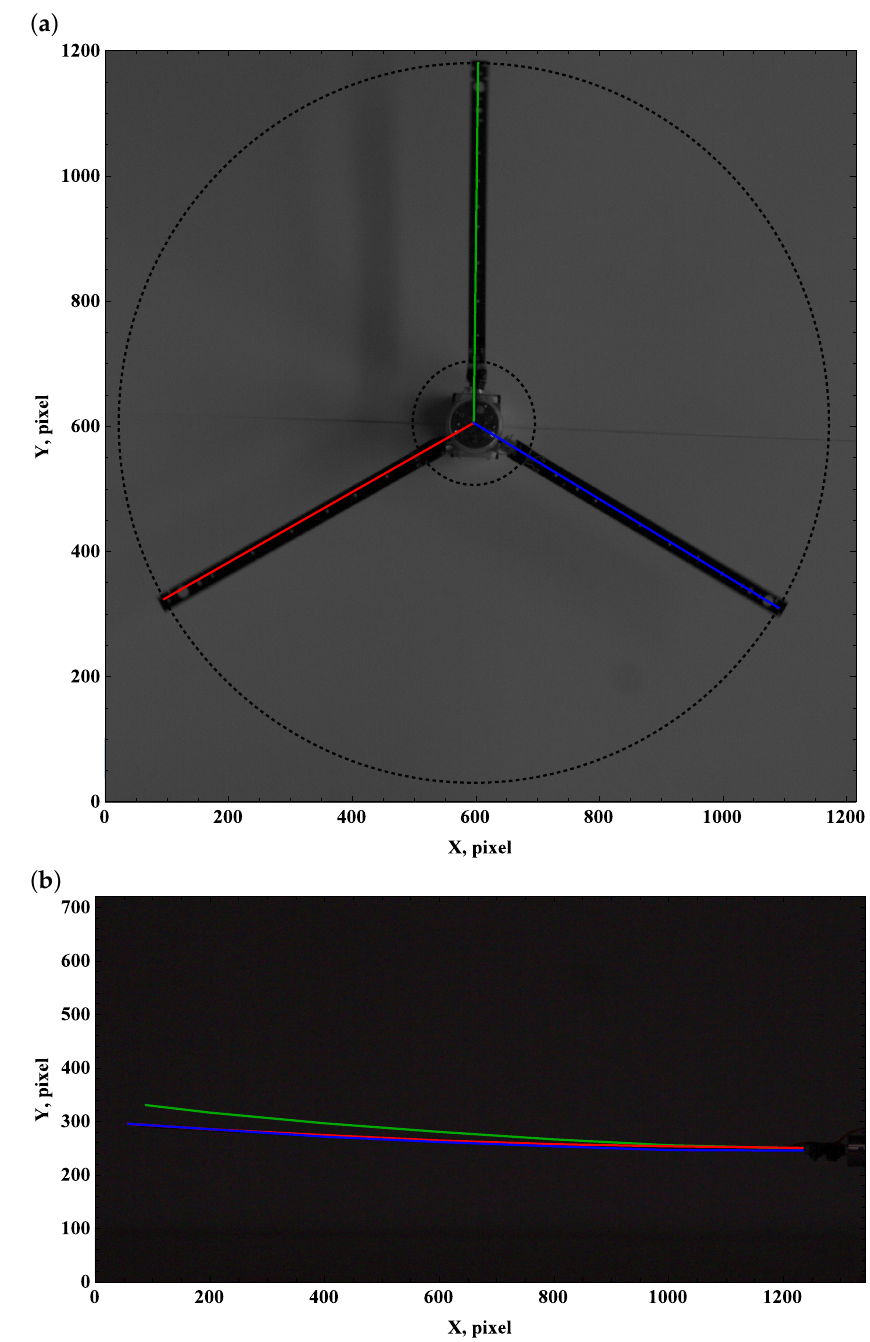
Figure 8. Preset angle 5 ◦ , angular speed 150 rpm: top view ( a ), side view ( b